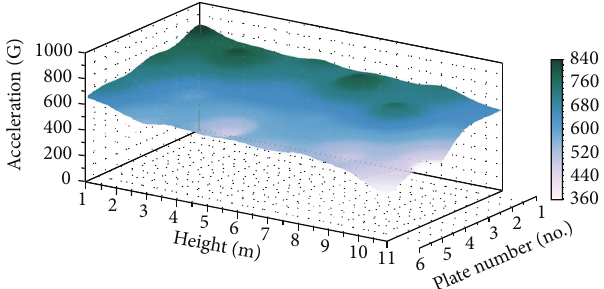
Figure 17: Result of accelerometer measurements at the points in which the accelerometers installed on the collecting plates (with six